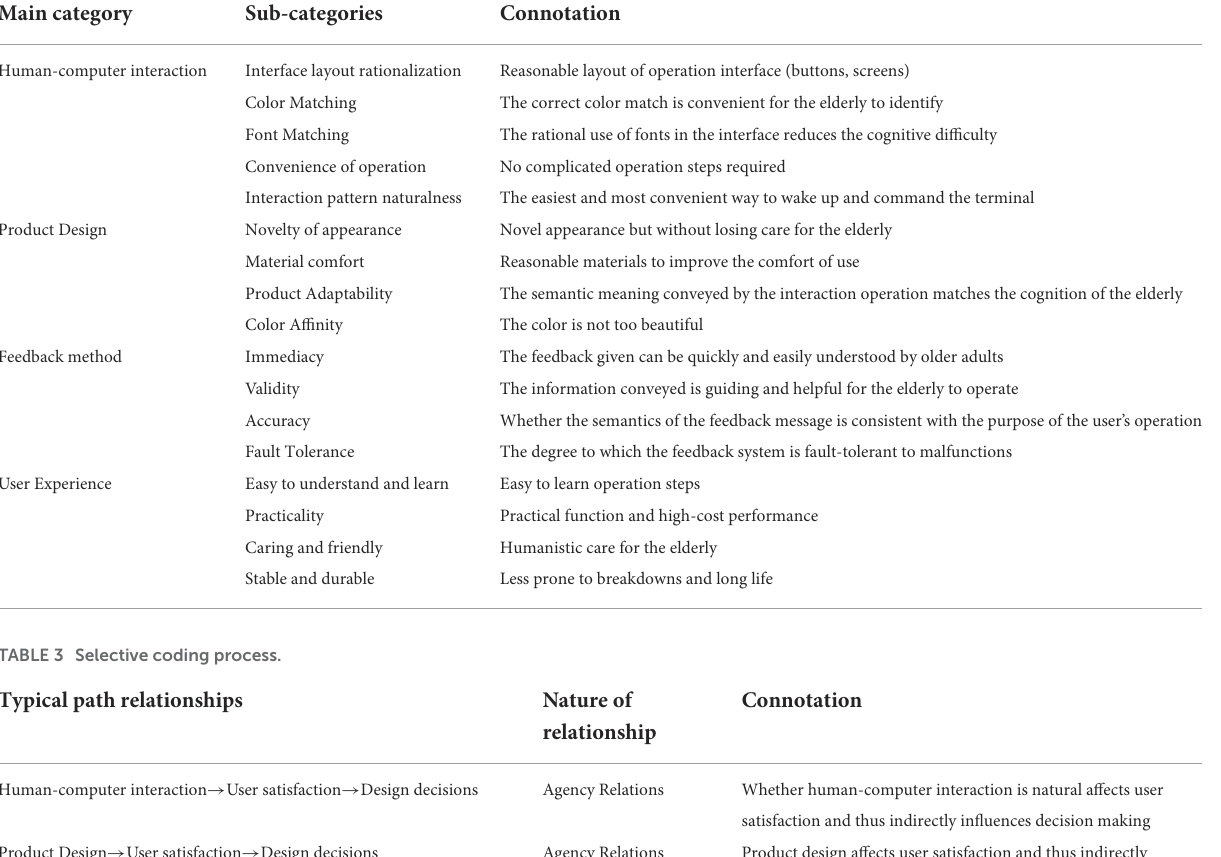
TABLE 2 Axial coding process.